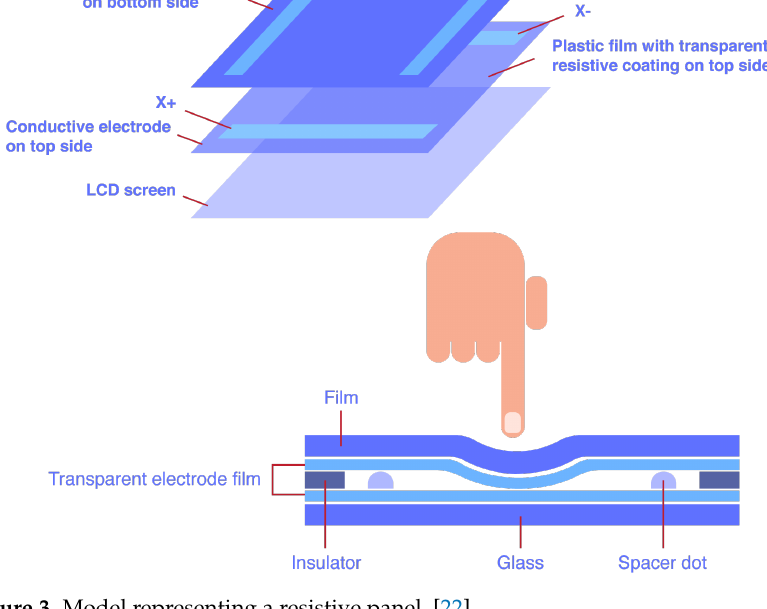
Figure 3. Model representing a resistive panel [22].